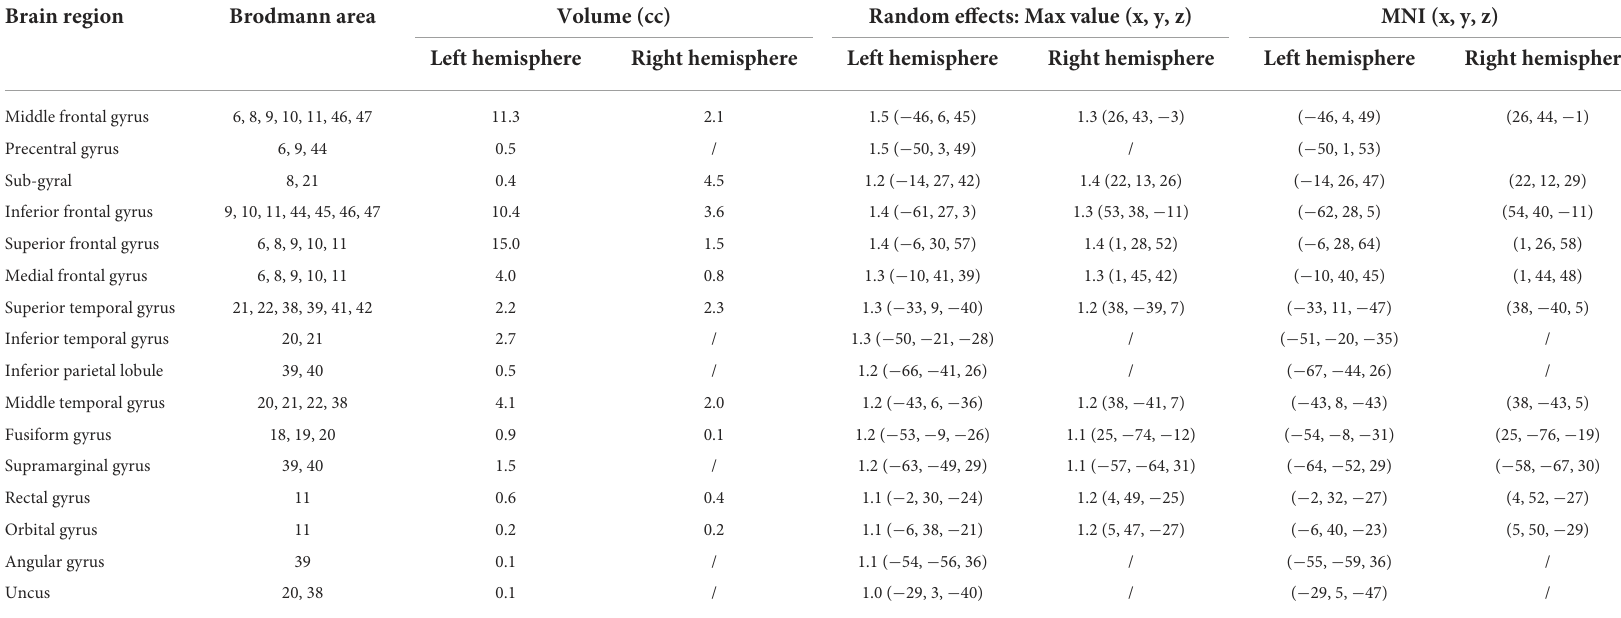
TABLE 2 ICLM results and MNI coordinates for the language network. Brain